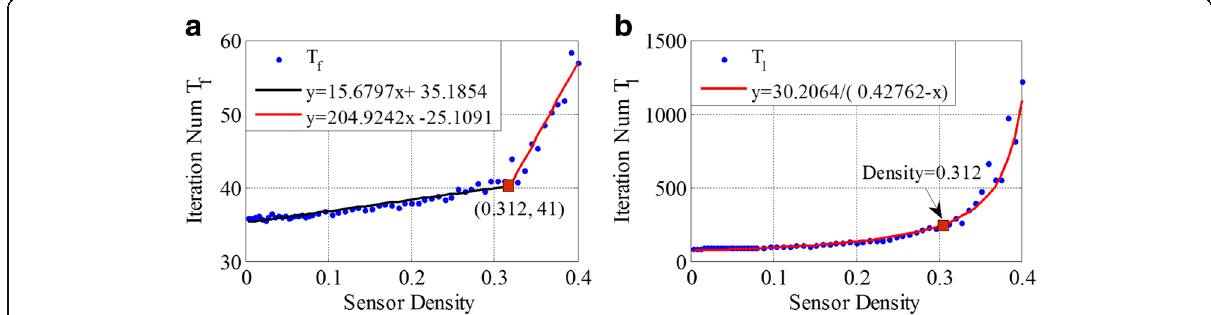
Fig. 11 The time computation complexity of TGRWI for various sensor densities. a Shows the trend of iteration number of the first path obtained by TGSARWI. b Shows the trend of iteration number for finding all the required connected